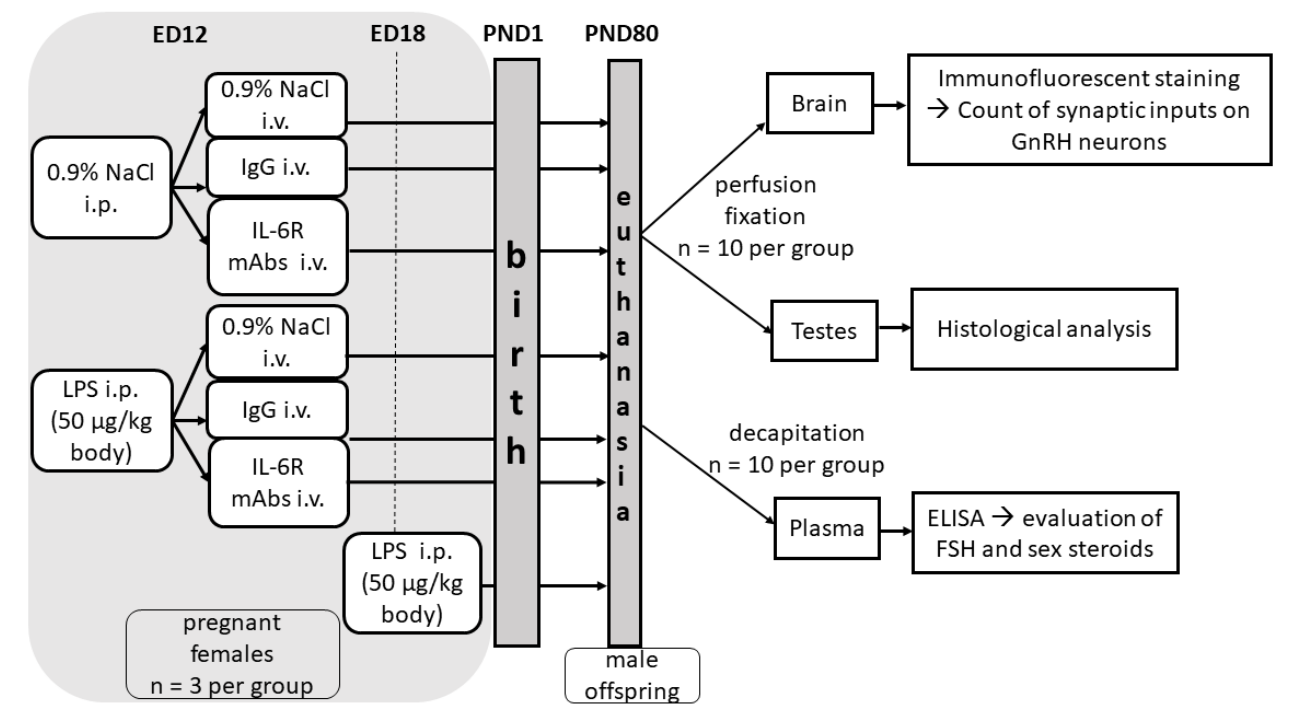
Figure 6. Scheme of the experimental design. A total of 18 pregnant rats (the first day of pregnancy was considered as ED1) were divided into two groups. On ED12, one group was injected intraperitoneally (i.p.) with 0.9% NaCl (control) and the second group with lipopolysaccharide (LPS; 50 µg/kg). At 40 min after the injections, the females of both groups were divided into 3 groups (n = 3 per group) and injected intravenously (i.v.) with 0.9% NaCl, IgG (1 mg/kg), or humanized IL- 6RmAbs (IgG1; 2 mg/kg), respectively. A separate group of females (n = 3) was injected with LPS on ED18. On postnatal day 80 (day of birth was designated as PND1), male offspring born from all groups of females were transcardially perfused under anesthesia (n = 10 per group) to obtain brain and testes samples or decapitated (n = 10 per group) to collect plasma. Brain samples were stained with anti-GnRH and anti-synapsin-1 antibodies, and synaptic inputs on GnRH neurons were counted. Testes underwent histological analysis. Follicle stimulating hormone (FSH) and sex steroid concentrations were detected in blood plasma using ELISA. 4.2. GnRH and Synapsin-1 Double Immunohistochemical Staining Male rats (n = 10 per group) born from females of all the groups on PND80 were anesthetized by inhalation of Forane (Aesica Queenborough, Queenborough, UK). A transcardial perfusion was then performed with 0.01 M phosphate-buffered saline (PBS, pH 7.2–7.4) and 10 mL paraformaldehyde (4% PAF in 0.1 M phosphate buffer) sequentially. After decapitation, the brains were isolated and immersed in 4% PAF for 2 h at room temperature for postfixation. After that, the brains were immersed in a 25% sucrose (Sigma, St. Louis, MI, USA) solution in 0.02 M PBS for 36 h for cryoprotection and then frozen in hexane cooled to −40 °C with liquid nitrogen. The 10 μm thick frontal sections were prepared using a cryostat (Leica Microsystems, Wetzlar, Germany) at −23– 25 °C, mounted on gelatin-coated glass slides, and dried at room temperature. The sections were rinsed in 0.01 M PBS with 0.3% Triton X-100 (PBST; Sigma, USA) and incubated in a wet chamber sequentially with: (1) 1:15 fetal bovine serum for 1 h at +20 °C; (2) a mixture of primary rabbit polyclonal anti-synapsin-1 (AB1543, Abcam, Cambridge, UK, 1:500), which is a presynaptic marker [36] [Lim et al., 2016] and mouse monoclonal anti-GnRH I (sc 32292, Santa Cruz Biotechnology, Dallas, TX, USA, 1:500) antibodies in PBST containing 1% bovine serum albumin (BSA; Sigma, USA) for 48 h at +4 °C; and (3) a mixture of secondary antibodies—donkey anti-mouse IgG conjugated with